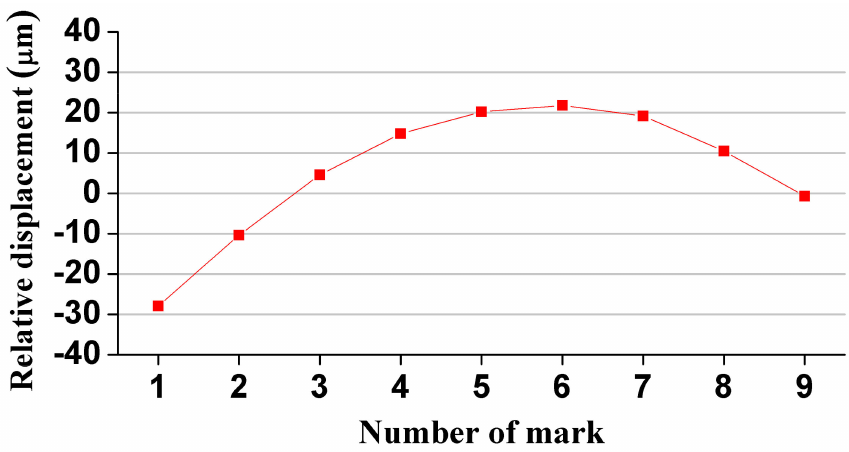
Figure 6. Strain measurement results along the cross direction (CD) of conventional